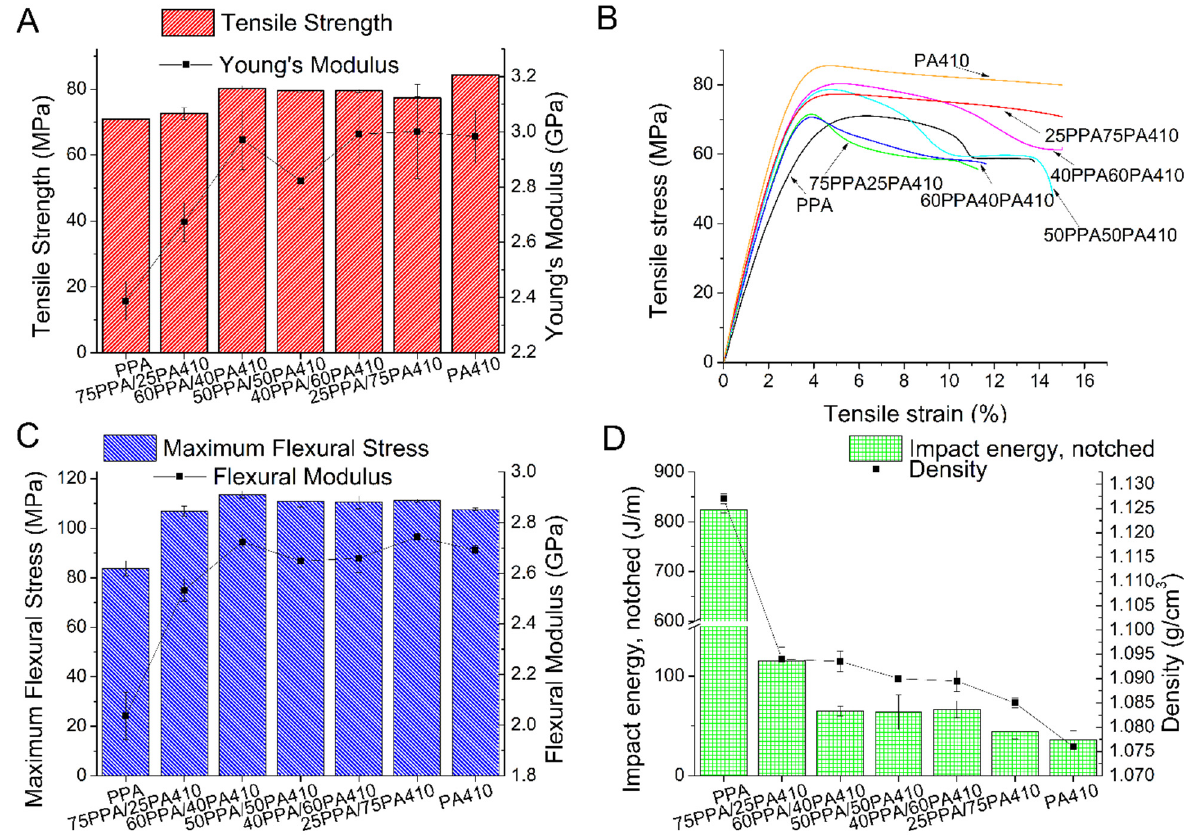
Figure 1. Mechanical properties of polymer blends of PPA/PA410. ( A ) Tensile properties; ( B ) tensile stress-strain curve; ( C ) flexural properties; and ( D ) impact energy and